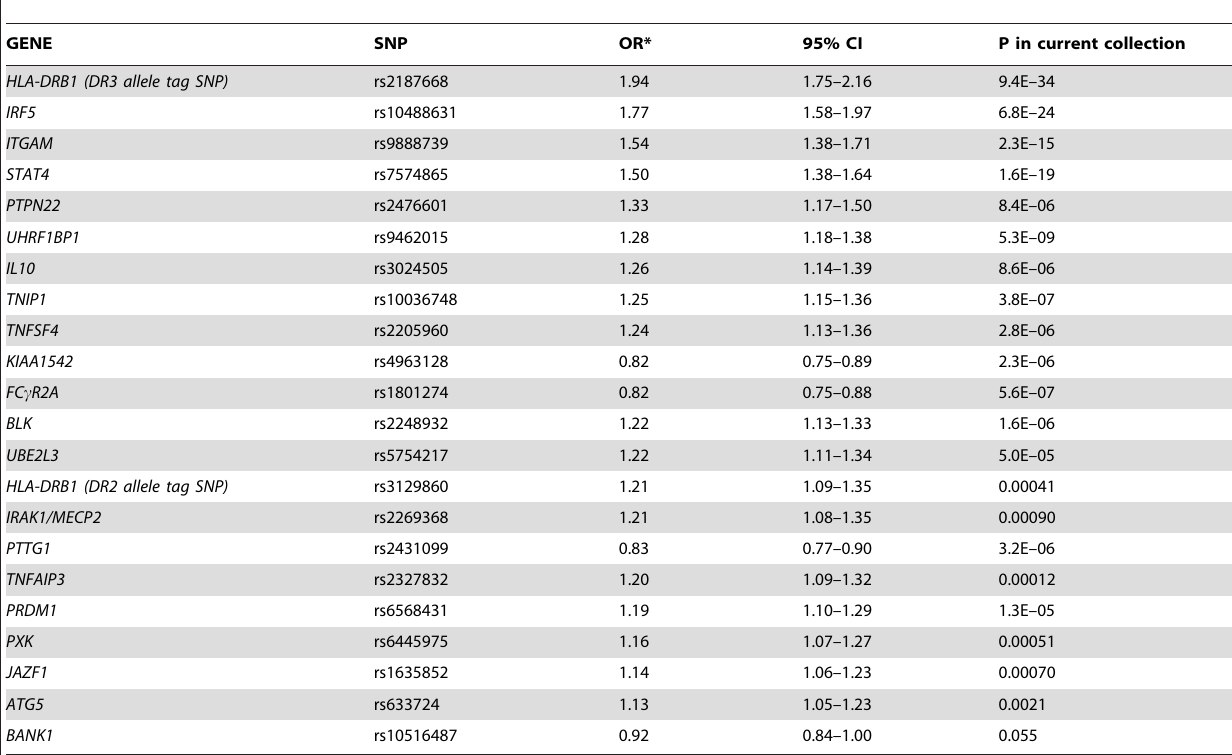
Table 1. Twenty-two SNPs used to compute the genetic risk score (GRS), with adjusted odds ratios for the current study.